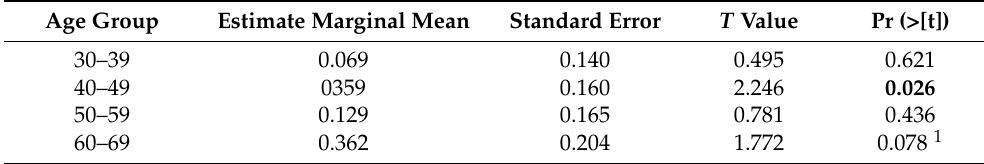
Table 5. Safety Communication by Age Group Estimated Marginal Means Across COVID Phase.